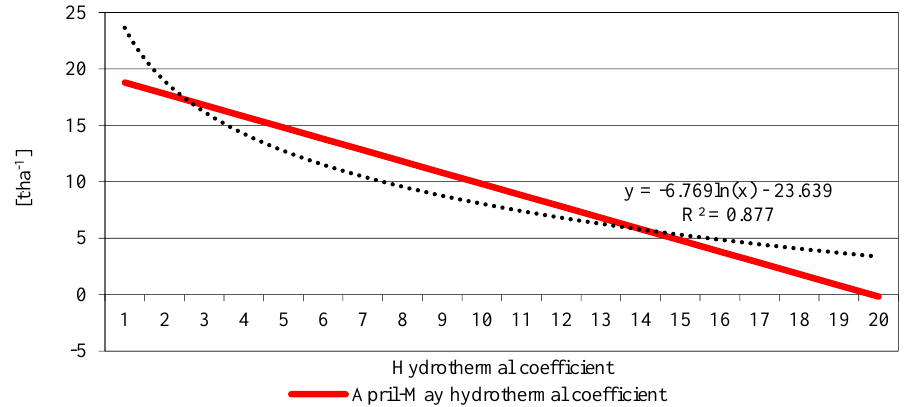
Figure 9. Partial dependence of the potato tuber yield on the value of the hydrothermal coefficient in April – May.